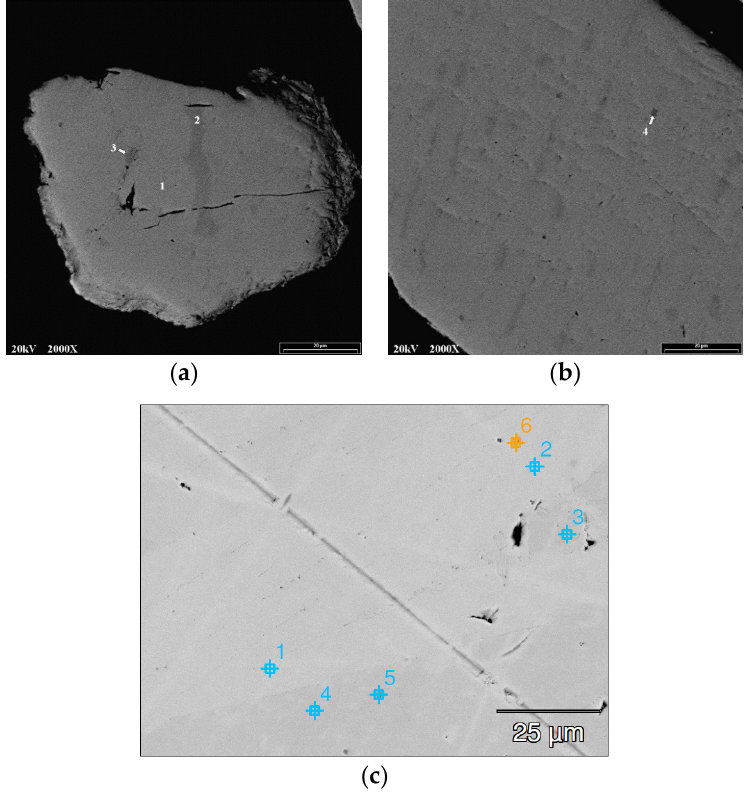
Figure 6. Scanning electron microscopy (SEM) images of a Zr-rich Zr 7 Ni 10 alloy sample showing representative phase distributions of ( a ) mainly Zr-rich phase and a smaller distribution of Ni-rich phases with ( b ) the presence of some amount of the Zr 2 Ni phase; and ( c ) a Ni-rich Zr 7 Ni 10 alloy sample consisting of mainly Ni-rich phase and the presence of some amount of the Zr 2 Ni phase. The bar on the right lower corner of the Zr-rich samples indicates a length of 20 μ m. Chemical compositions associated with the numbered areas are listed in Table 6.